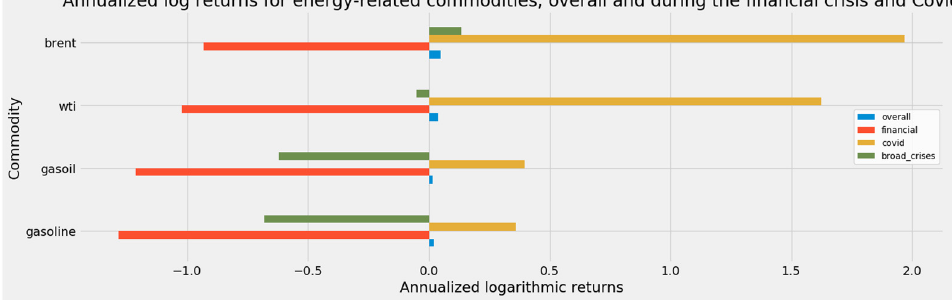
Figure 48. Annualized logarithmic returns on energy-related commodities, overall and during the financial crisis and the pandemic.